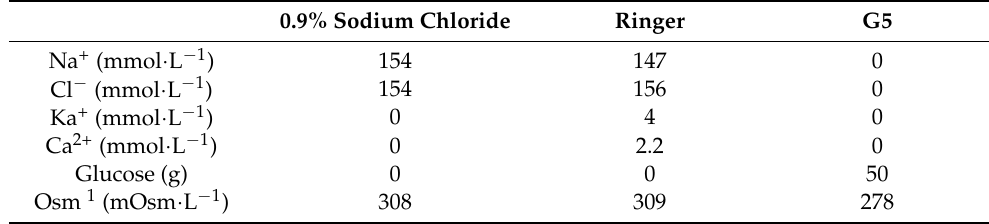
Table 1. Electrolyte composition and osmolarity of the sodium chloride, G5 and Ringer